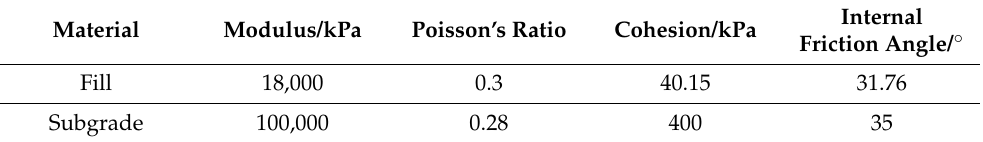
Table 3. Material mechanical parameters used in the numerical simulation.